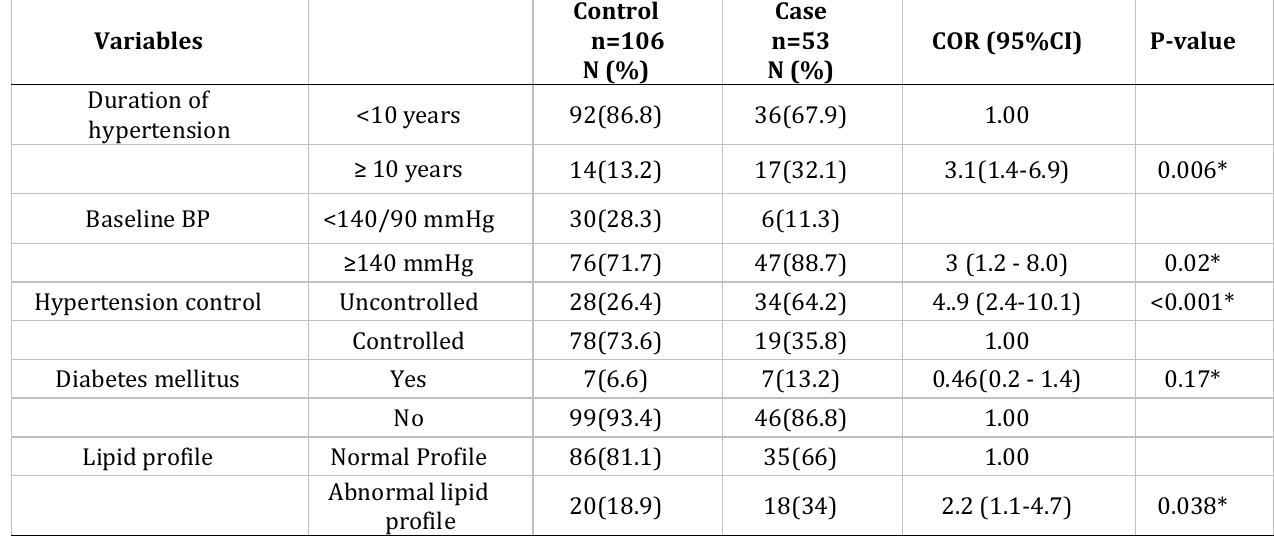
Table 3. Medical factors among cases and controls at Gondar University Referral Hospital during